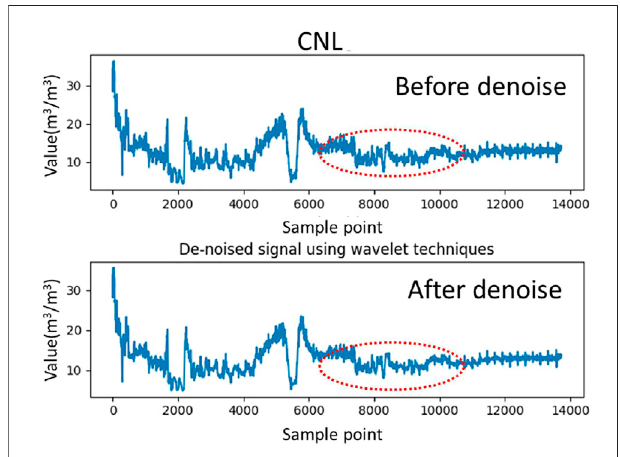
FIGURE 3 | Effect of denoising for the CNL logging